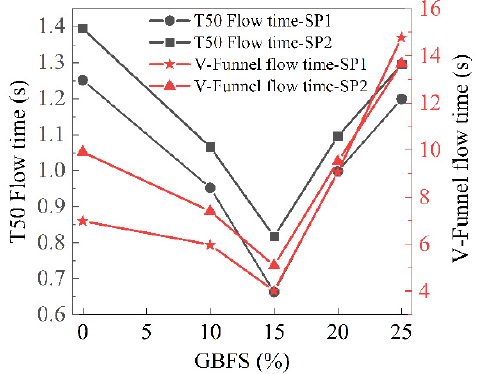
Figure 10. The effect of GBSF content on the T50 flow time and V-Funnel flow time of SCC (SP1 is a polycarboxylate-based superplasticizer and SP2 is a naphthalene sulphonate-based superplasti- cizer) [44].